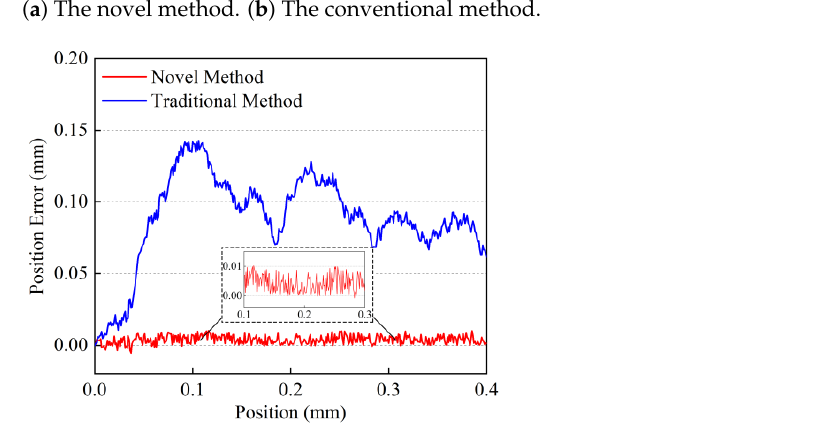
Figure 11. Position errors of the two methods between the two modules without external disturb- ance.